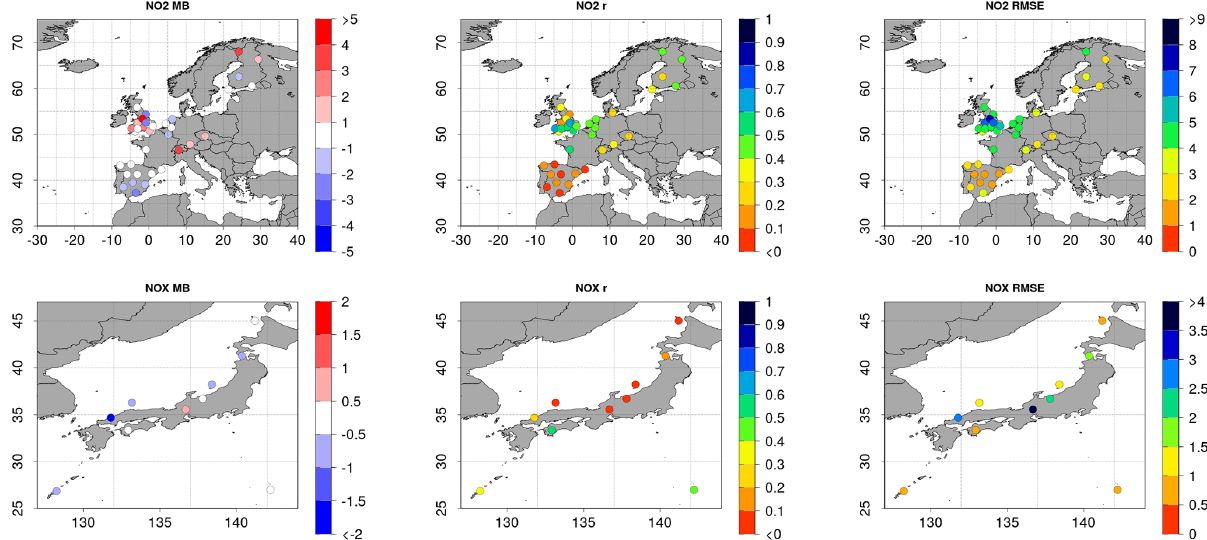
Figure 8. NO 2 (top) NO x (bottom) and spatial distribution of mean bias (MB, ppb) (left panel), correlation ( r ) (middle panel) and RMSE (ppb) (right panel) at all rural EMEP and EANET stations,